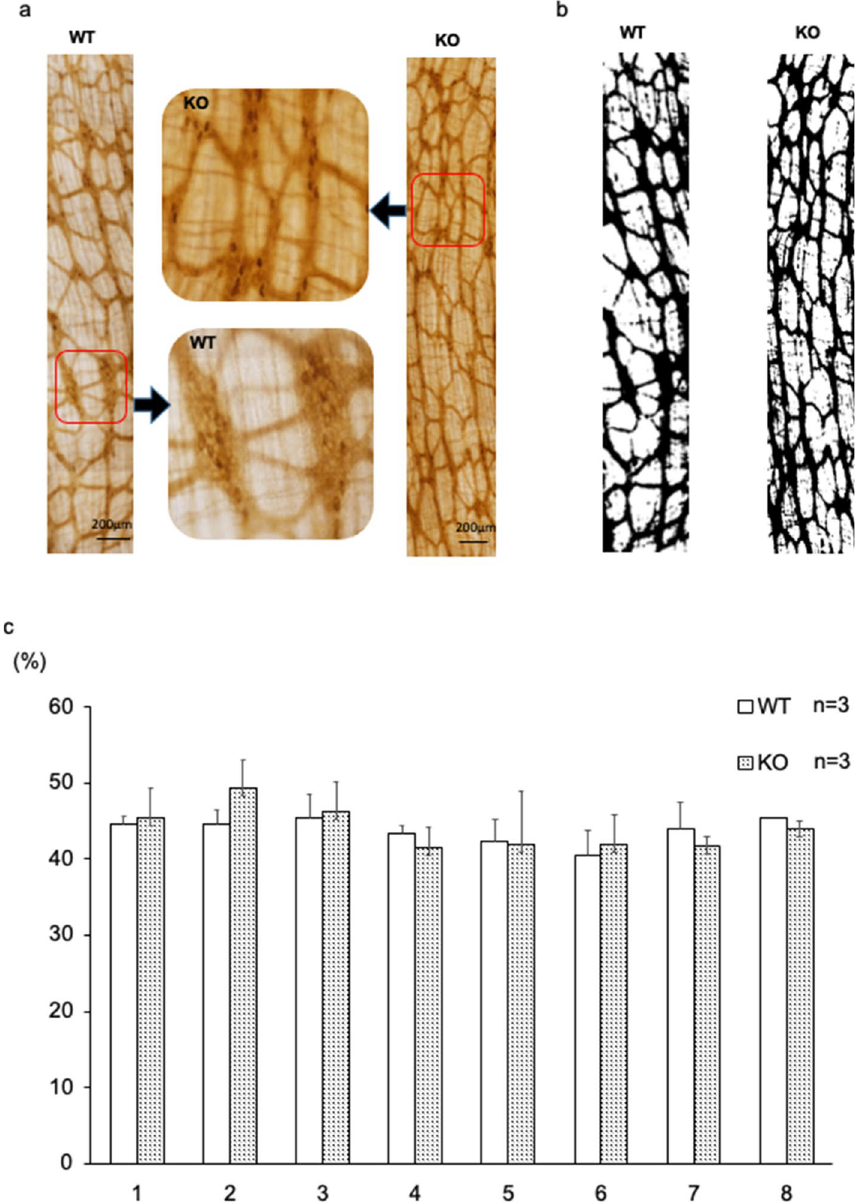
Figure 5. Area of acetylcholinesterase-positive enteric neurons in BALB/c Kif26a-KO mice. ( a ) Images of acetylcholinesterase-positive neurons in the most proximal part of the colon in 7-week-old WT and KO mice. A high-magnification view of the area demarcated in the middle panel. ( b ) Binarized image using ImageJ software. ( c ) Area percent of acetylcholinesterase-positive nerve fibers for each segment, as determined using ImageJ software. No significant difference was